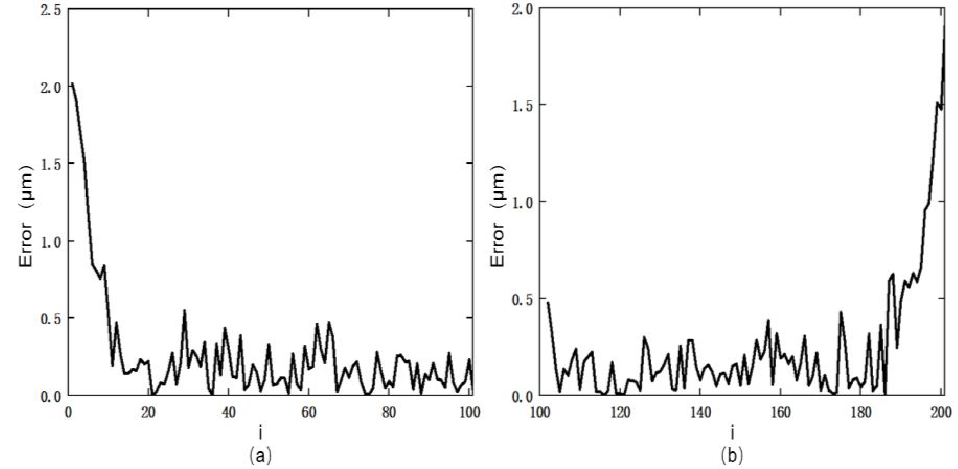
Figure 12. Fitting error diagram of model data and experimental data: ( a ) ascending segment; ( b ) descending